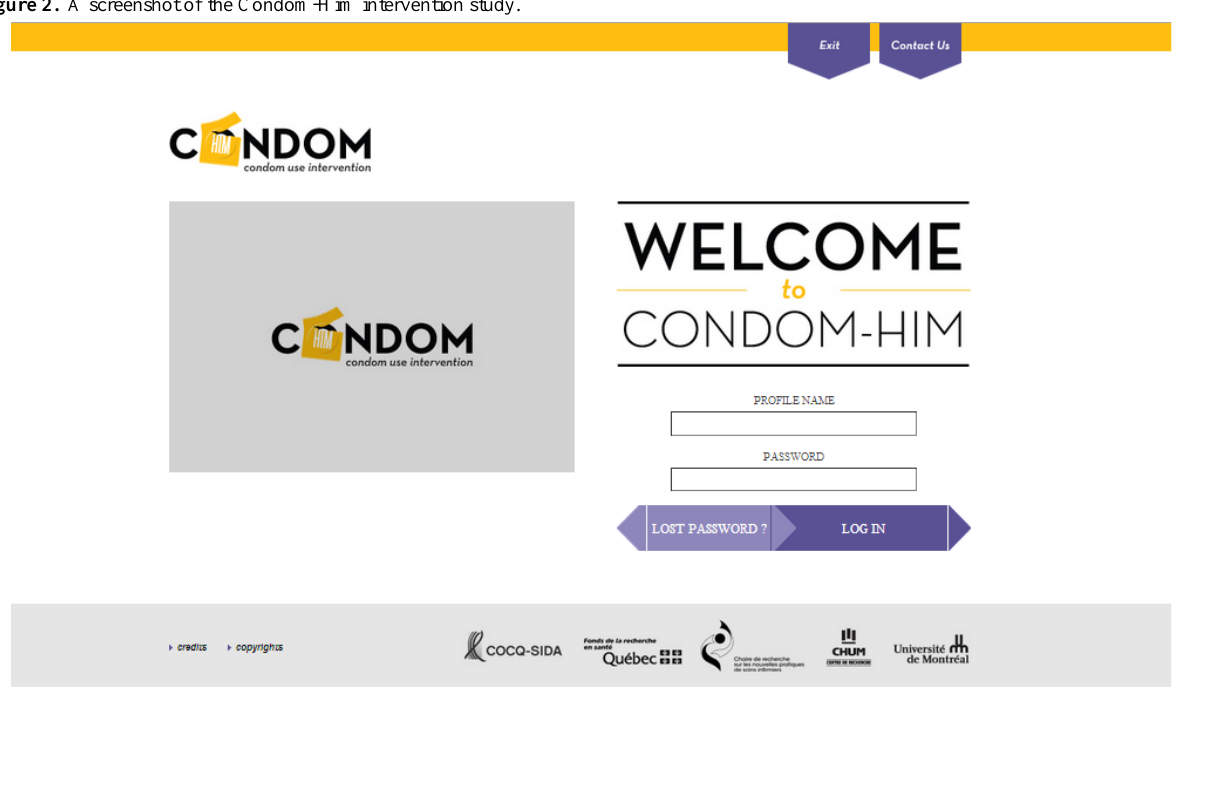
Figure 2. A screenshot of the Condom-Him intervention